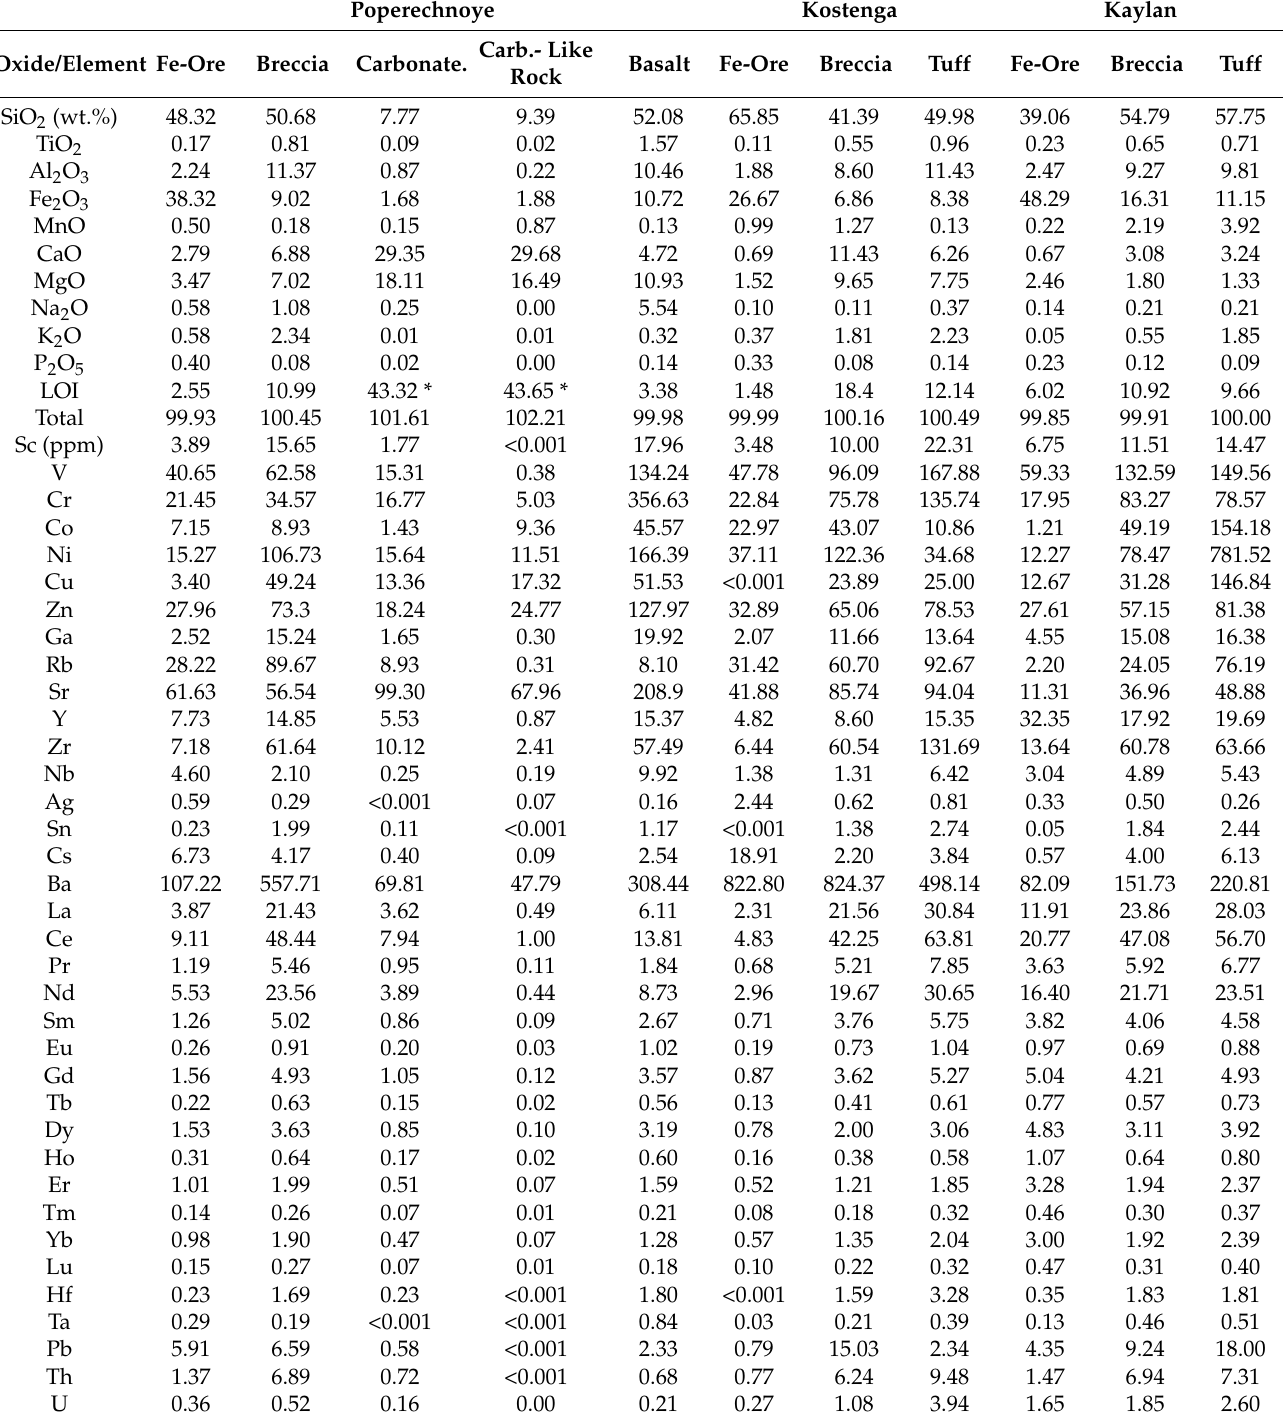
Table 1. Chemical composition of magnetite-hematite ores and magmatic rocks from the Poperechnoye, Kostenga, and Kaylan